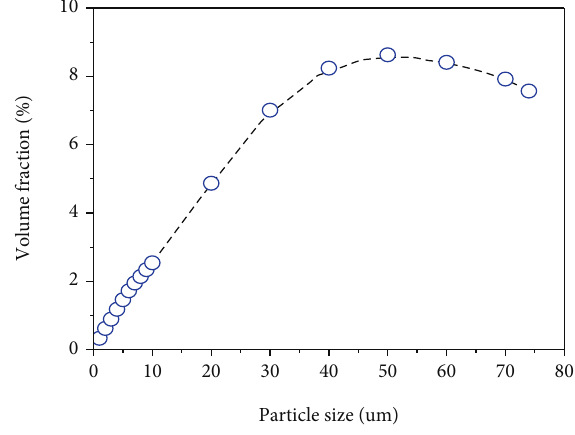
Figure 15: Volume fraction of tailing sand particle residue in geotextile compared with original sample.